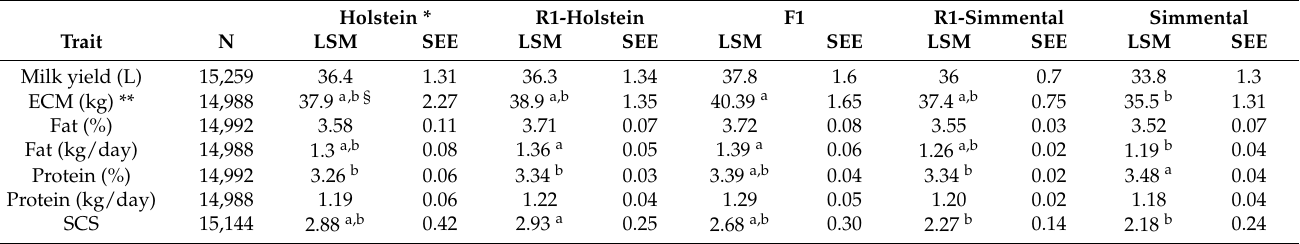
Table 2. Least squares means (LSM), standard errors of estimation (SEE), and observation numbers (N) for variables of the automatic milking system (AMS) related to milk yield and composition, and somatic cell score (SCS) of Holstein, R1-Holstein, F1-Crossbred, R1-Simmental, and Simmental